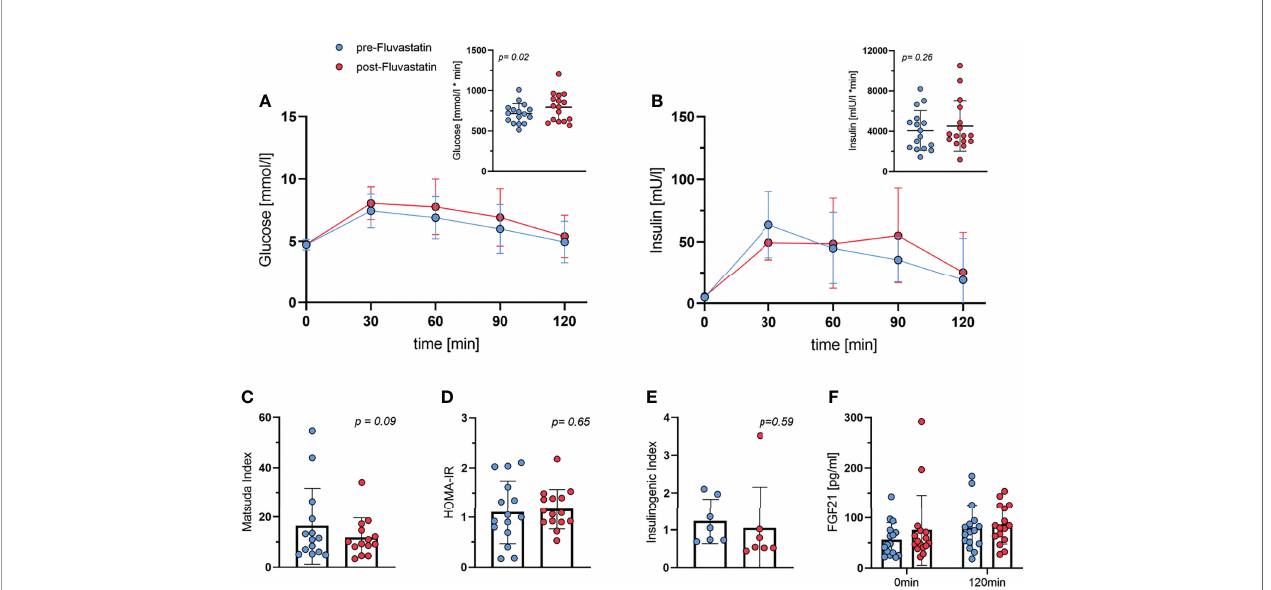
FIGURE 3 | Oral Glucose tolerance test. (A) Glucose during oGTT both before and after two weeks of treatment with fl uvastatin and respective area under the curve, p = 0.02. (B) Insulin levels during oGTT and area under the curve, p = 0.26. (C) Matsuda Index, p = 0.09. (D) HOMA-IR, p = 0.65. (E) Insulinogenic Index; p = 0.59. (F) FGF21 concentration at baseline (0min) and at the end (2h) of the oGTT both before and after two weeks of fl uvastatin administration. Effect of time after ingestion of glucose p = 0.01, effect of fl uvastatin p = 0.2, interaction between time x fl uvastatin p = 0.47.